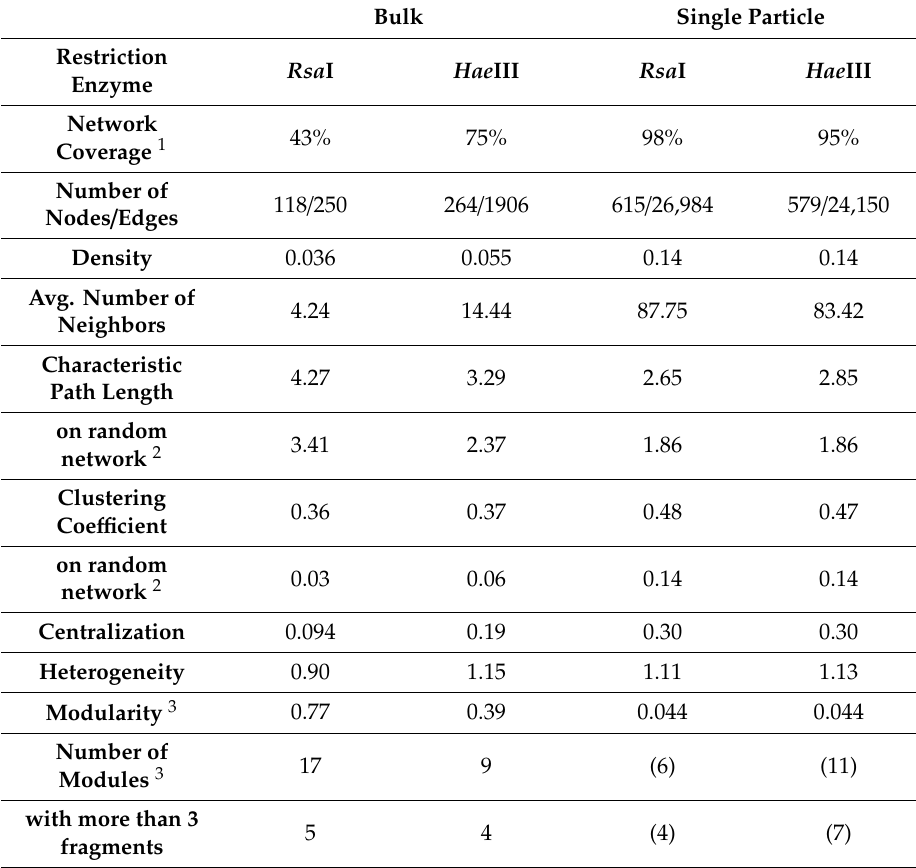
Table 2. Topological parameters of co-occurrence